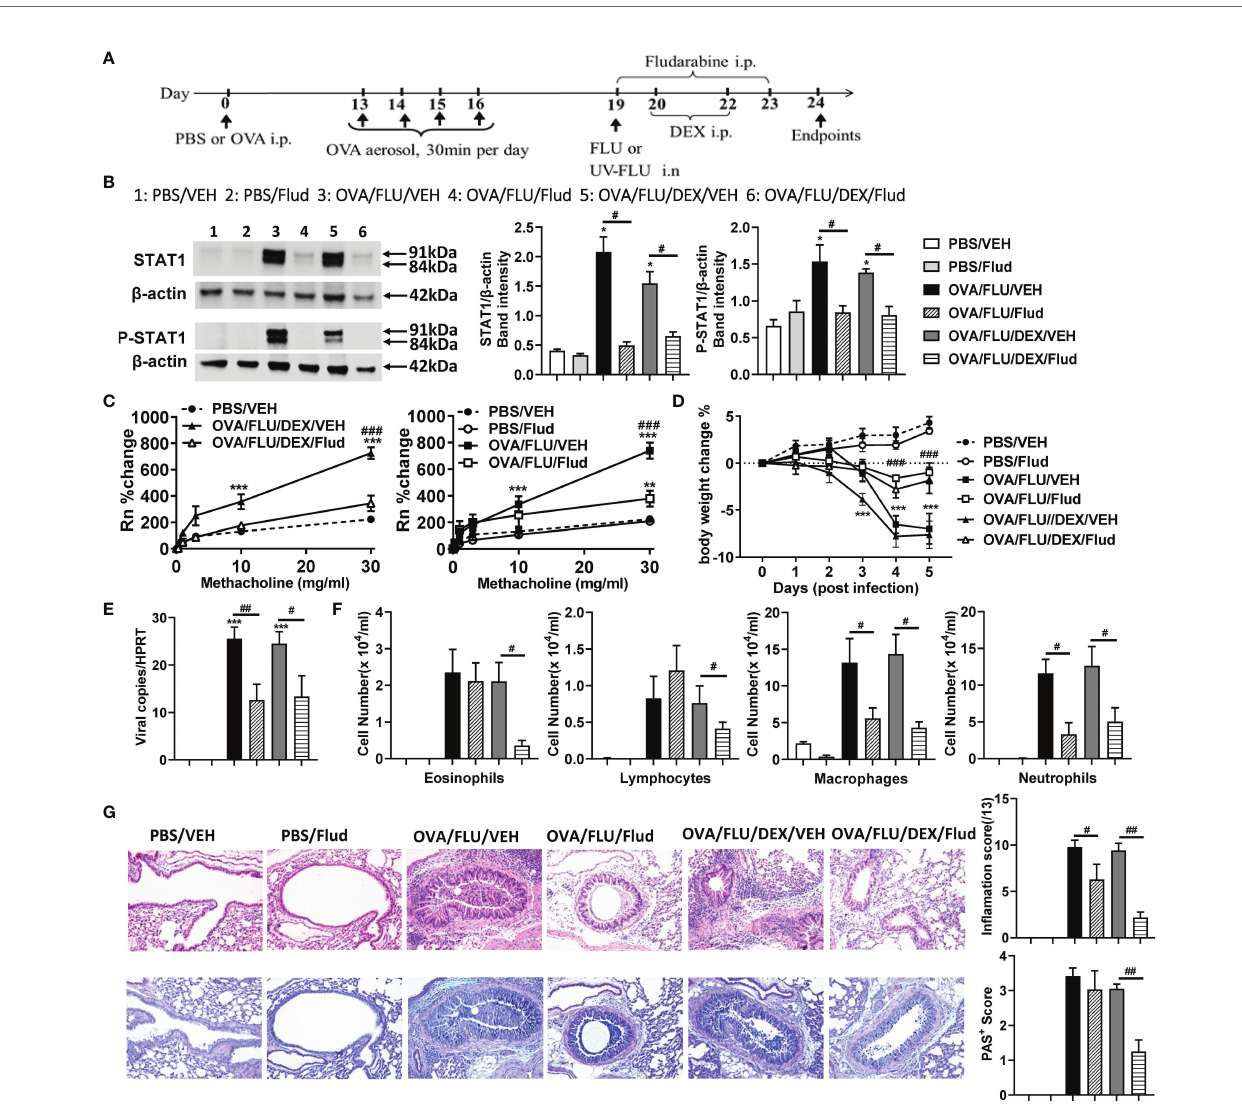
FIGURE 5 | Fludarabine treatment inhibits STAT1 production and suppresses AHR and in fl ammation in the asthma exacerbation model. BALB/c mice were sensitized i.p. with OVA or PBS on day 0 and exposed to OVA aerosol on days 13 – 16. Some mice were inoculated with FLU on day 19, treated with Dex on days 20 and 22, or injected with Fludarabine from day 19-23 as indicated. Lung function and airway in fl ammation were assessed on day 24. (A) experimental design; (B) Western blot analysis con fi rmed the ef fi ciency of Fludarabine inhibiting STAT1, using anti-STAT1 Ab (Stat1 a , Stat1 b ) and anti-phospho-STAT1 (Tyr701) Ab. b -actin (42 kDa) was used as a loading control. The relative quanti fi cation of STAT1 proteins were performed using Image Lab software 6.1. (C) AHR; (D) body weight changes over 0 dpi; (E) viral load in lung tissue; (F) differential in fl ammatory cell counts for neutrophils, lymphocytes, macrophages, and eosinophils in BALF; (G) histologic examination of lung tissue stained with H&E or AB-PAS for assessment of in fl ammatory score or hyperplasia of mucus-secreting goblet cells, respectively. All histological images were randomly selected using a 20 × magni fi cation lens. Data are presented as mean ± SEM (n = 6-8 mice/group) and are representative of three independent experiments. *Designates signi fi cant differences from PBS-treated controls (*p < 0.05, **p < 0.01, ***p < 0.001). #Designates signi fi cant differences between Flud-treated and isotype-treated groups (#p < 0.05, ##p < 0.01, ###p <